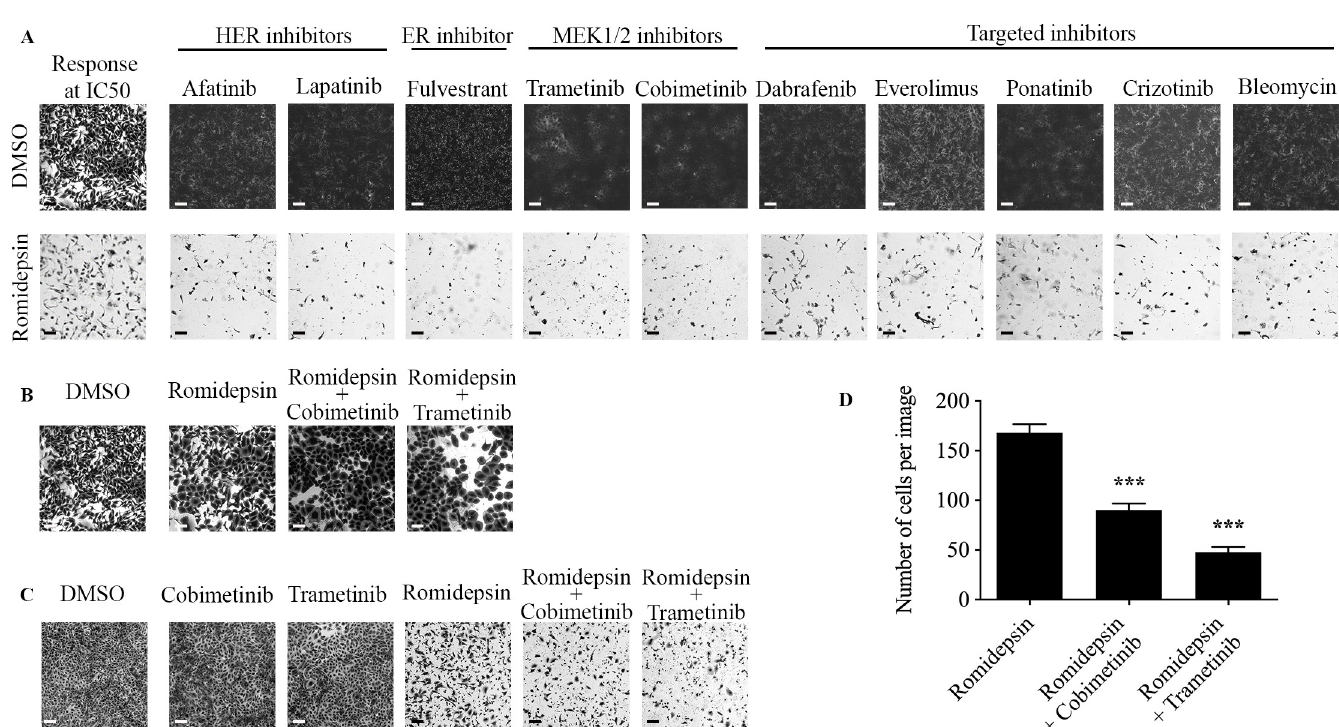
Fig 6. Romidepsin sensitizes TU-BcX-4IC cells to select oncology drugs. TU-BcX-4IC cells were treated only with agents from the NCI-approved oncology set or pre-treated with romidepsin (50 nM, 72 hours) prior to the oncology agents. Crystal violet staining was performed to visualize differences in cell viability between the groups. (A) Romidepsin sensitized TU-BcX-4IC cells to HER-targeted inhibitors (afatinib, lapatinib), the ER inhibitor fulvestrant, MEK1/2 inhibitors (trametinib, cobimetinib), as well as other targeted inhibitors (dabrafenib, everolimus, ponatinib, crizotinib), and bleomycin. Representative images are shown at 40X magnification. Response of both treatment groups to fluorouracil is shown as an example of baseline response to romidepsin, as well an example of 50% response of TU-BcX-4IC cells. (B) TU-BcX-4IC cells were pre-treated with romidepsin (50 nM) for 24 hours before treatment with cobimetinib and trametinib (1 μ M) for an additional 24 hours. (C) TU-BcX-4IC cells were co-treated with romidepsin (50 nM) and cobimetinib or trametinib (1 μ M) for 72 hours. (D) Quantification of cells remaining when cells were treated with romidepsin alone or pre-treated with romidepsin for 24 hours followed by cobimetinib or trametinib. Notably, the abundance of cells in the DMSO group prevented quantification of this treatment control and is not included in the graph. All scale bars represent 0.25 mm. ��� p < 0.001.